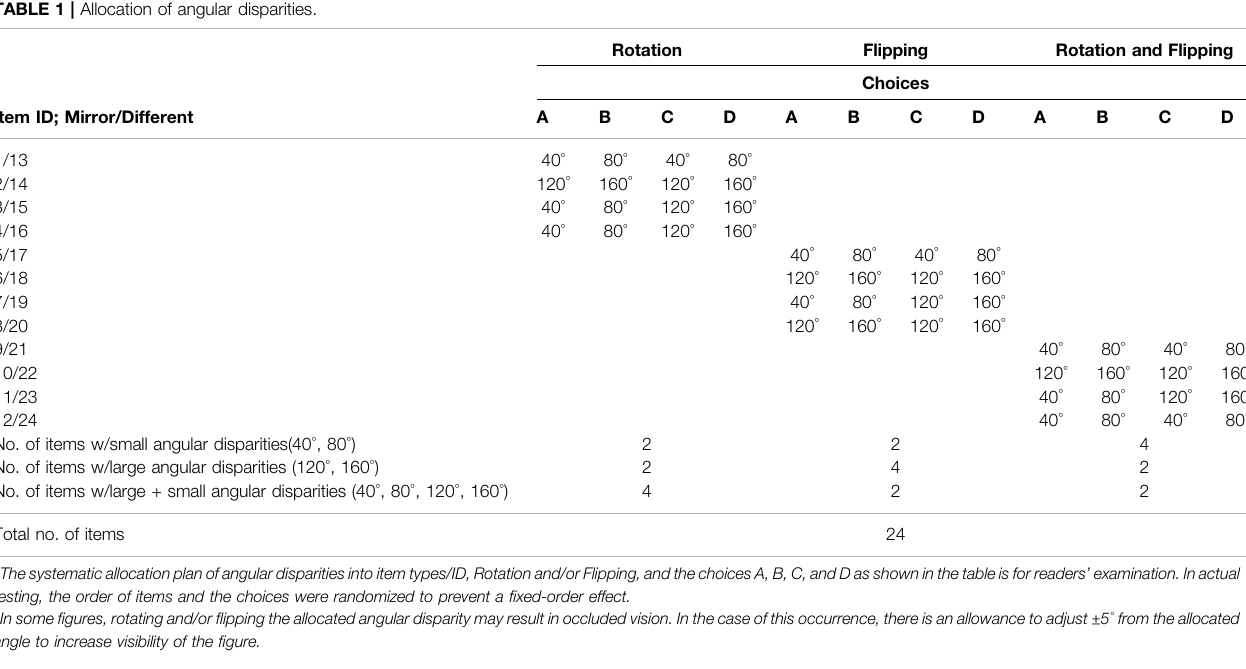
TABLE 1 | Allocation of angular disparities.